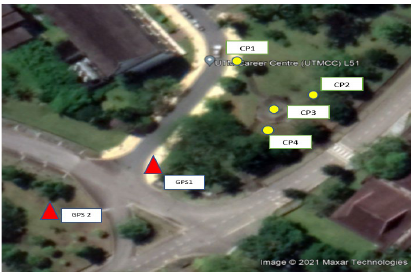
Figure 2.2 Proposed control station (GPS point) and checkpoints (CP)